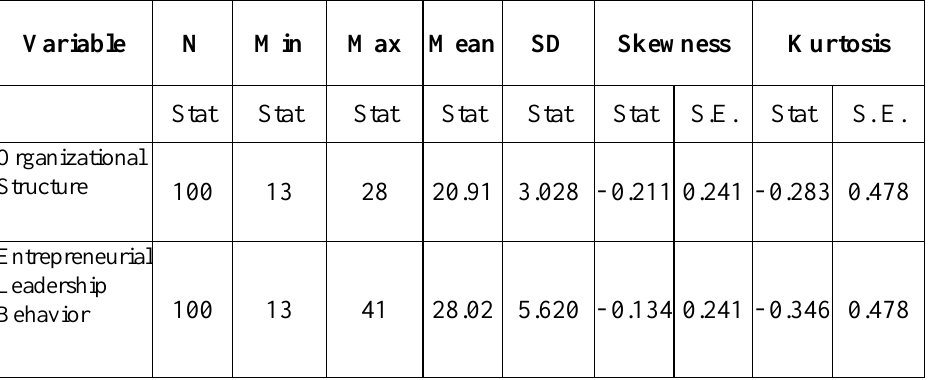
Table 06: Univariate Normality descriptive statistics of the